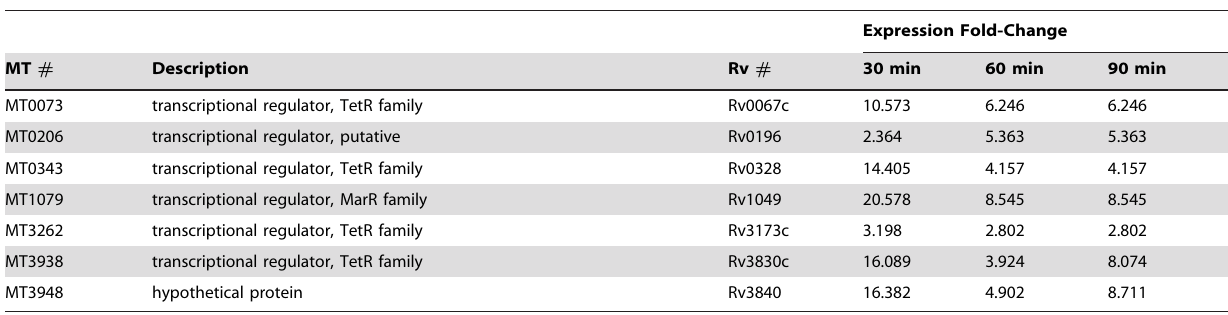
Table 10. Negative Regulators Expressed in Mtb post-diamide treatment.